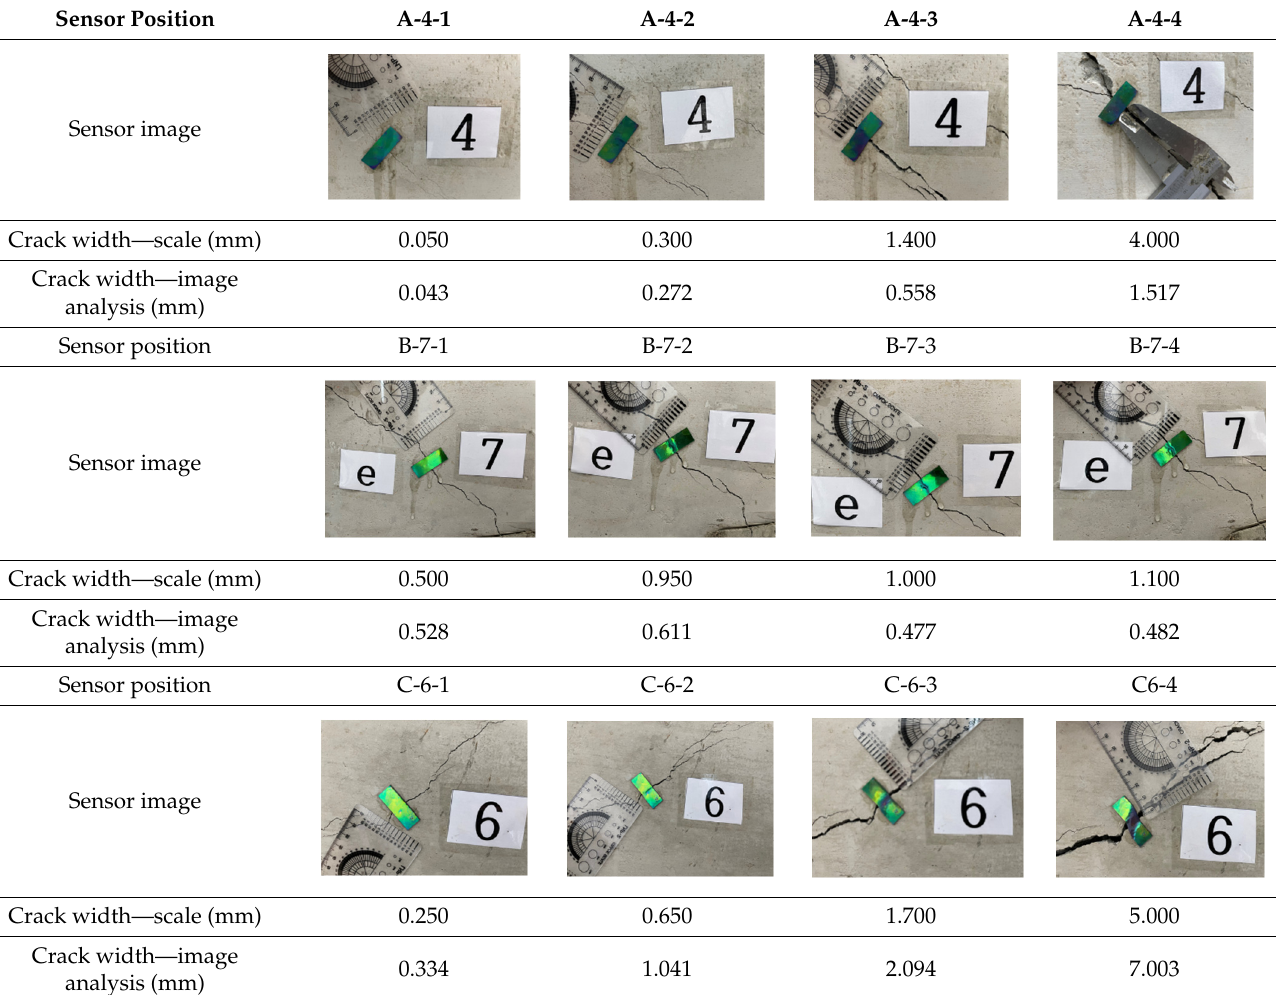
Table 6. Comparison of the crack-width results obtained via the image analysis and crack scale.